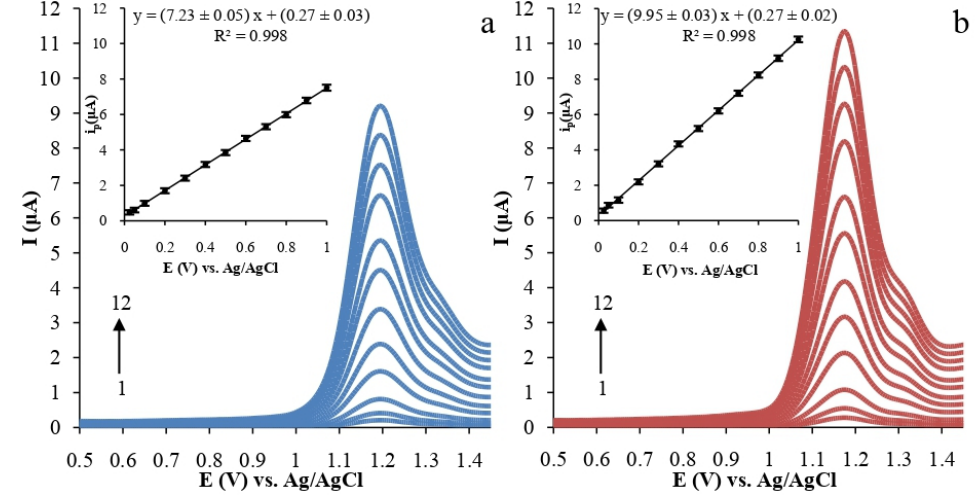
Figure 7. DPV of ( a ) R-Prp and ( b ) S-Prp solutions of various concentrations on GCE/PEC–[Cu( S -Ala) 2 ]–[Cu( S -Phe) 2 ]: 0.025 (1), 0.05 (2), 0.1 (3), 0.2 (4), 0.3 (5), 0.4 (6), 0.5 (7), 0.6 (8), 0.7 (9), 0.8 (10), 0.9 (11), 1 (12) mM (0.05 M sulfuric acid, potential scanning rate 0.2 V/s). Insets: the corresponding